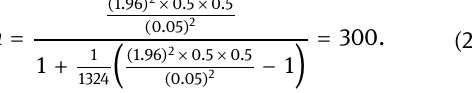
Table 3: Bartlett test, KMO, and signi fi cance level